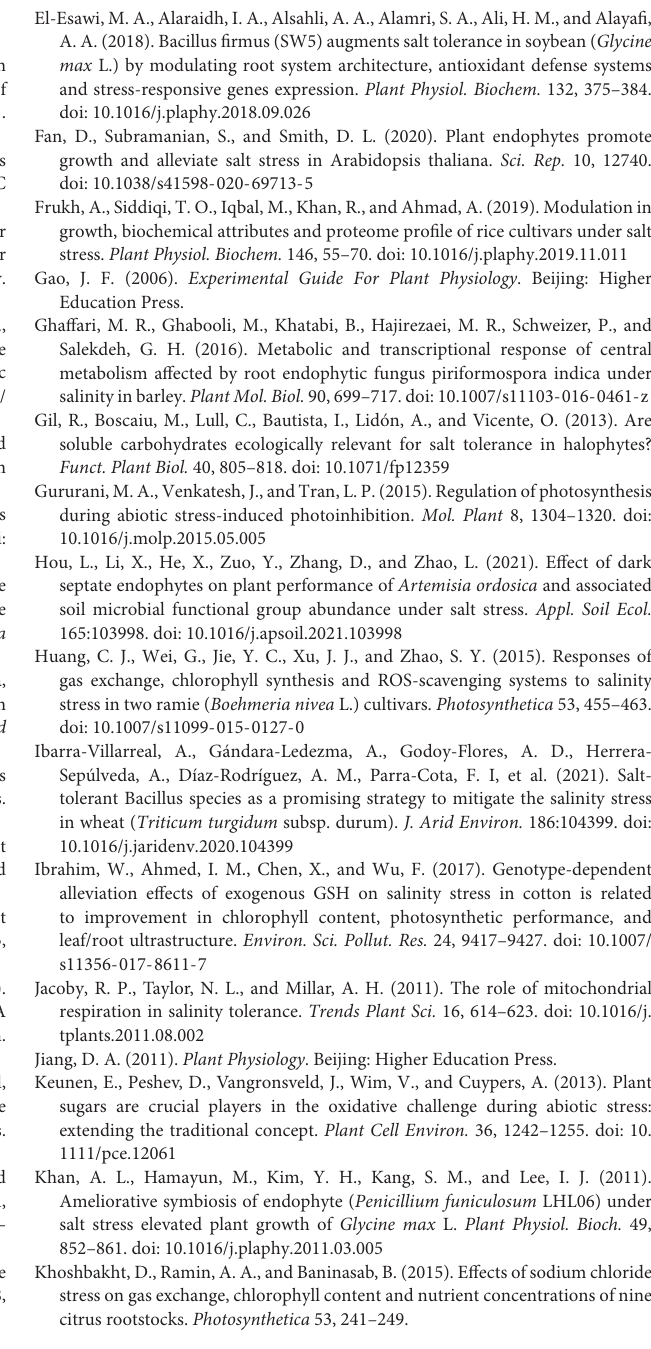
photosynthetic organisms pathway, starch and sucrose metabolism, and EMP and TCA cycle indexes to the principal components. The depth of the color of the arrow line represents the degree of contribution. The angle of the arrow line represents correlations. CK, control group; S, salt stress group; CK + G2, control combined with the G2 group; S + G2, salt stress combined with the G2 group. Supplementary Figure 3 | Expression of carbohydrate metabolism-related genes (RT-PCR) in G. uralensis in four treatments (CK, CK + G2, S, and S + G2). CK, control group; S, salt stress group; CK + G2, control combined with the G2 group; S + G2, salt stress combined with the G2